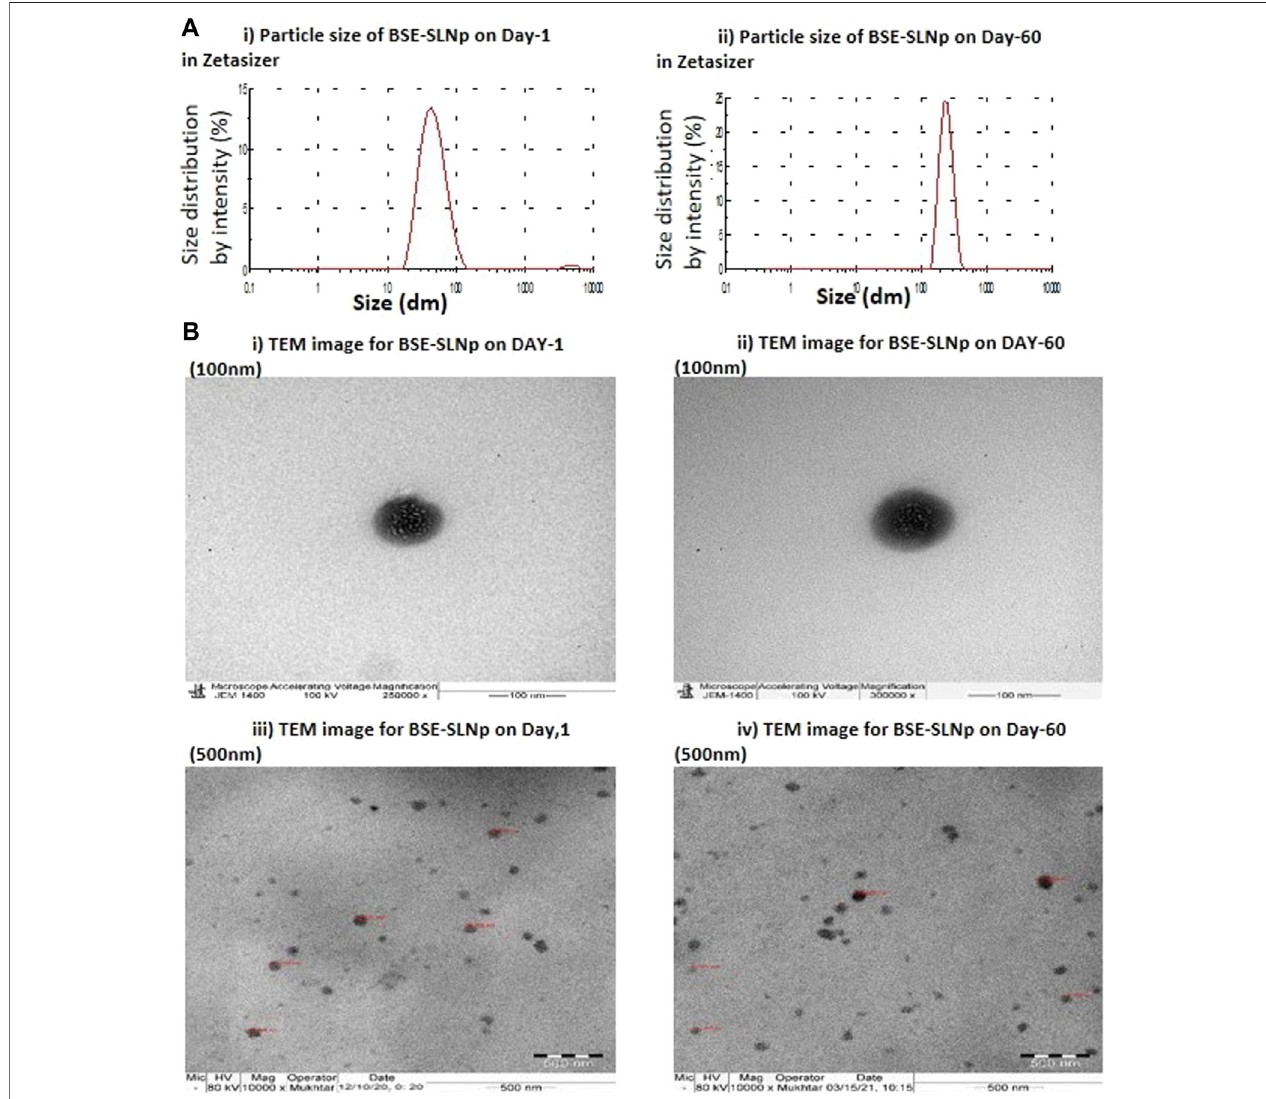
FIGURE 1 | Particle size for basil seed extract (BSE) and basil seed extract loaded solid lipid nanoparticle (BSE-SLNp) on Day 1 (1Ai) and Day 60 (1Aii) . Transmission electron microscopic (TEM) image with 100-nm sale (1Bi, ii) and 500-nm scale (1Biii, iv) on Day 1 (1Bi, iii) and Day 60 (1Bii, iv) .